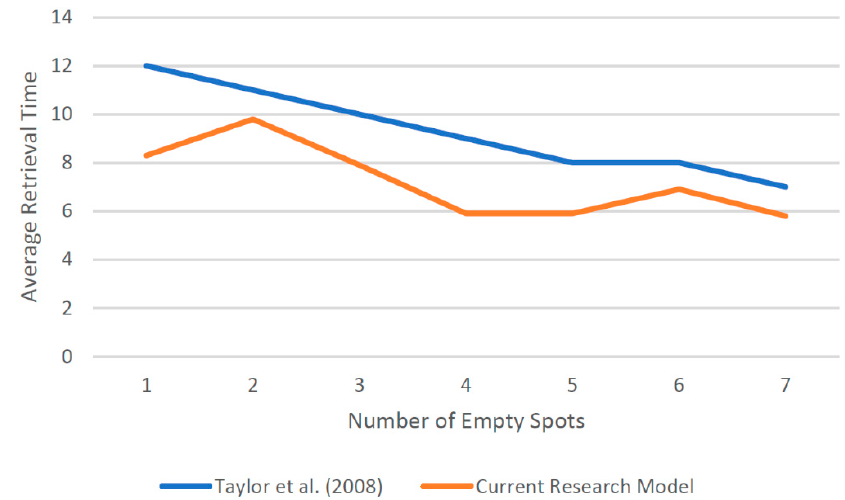
Figure 19. Comparison of our algorithm’s and Taylor and Gue’s (2008) results in the I/O distribu ‐ tion configuration.